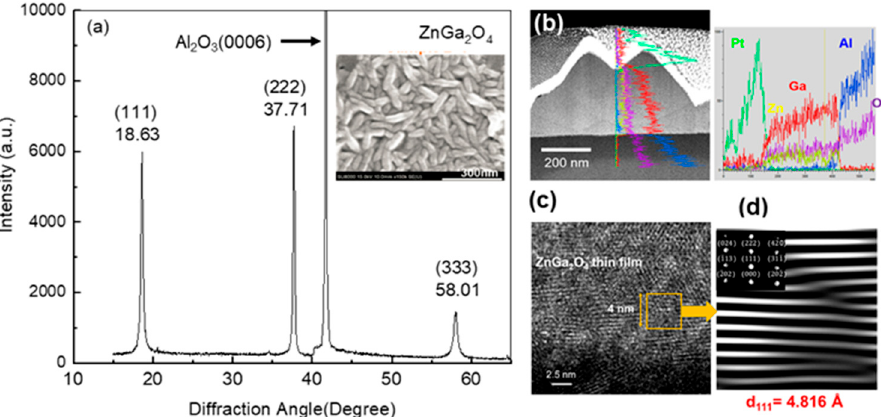
Figure 2. Material characteristics of the as-grown ZGO film. ( a ) θ /2 θ -scan XRD pattern and corre- sponding top-view SEM micrograph, shown in the inset, of the film. ( b ) Microstructure and corre- sponding elemental distribution measured by TEM and EDS. ( c ) Lattice-resolved TEM image taken from the film, and ( d ) Fourier-filtered lattice-plane image converted from the area marked with an orange rectangular in ( c ), as well as a corresponding fast Fourier transform pattern shown in the inset of ( d ).